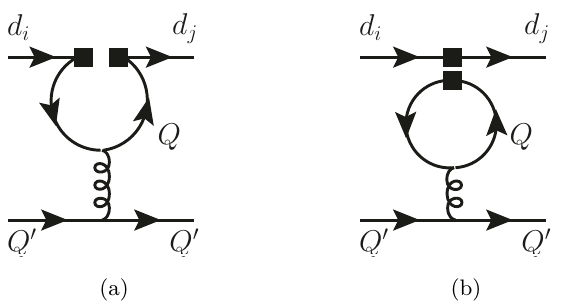
Figure 2 . The QCD-penguin insertions at one-loop of non-leptonic operators with open [left] and closed [right] fermion loops. The inserted operator can either be a current-current one (the open loop only) or a penguin one (both cases). The analogous QED-penguin insertions are given by diagrams where the gluon is replaced by a